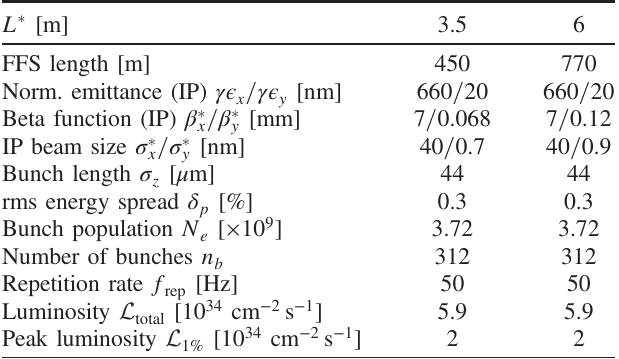
TABLE I. CLIC 3 TeV design parameters.